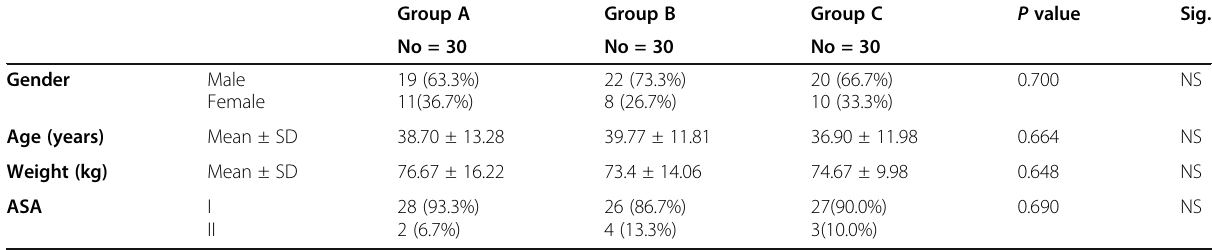
Table 1 Comparison between groups A, B, and C as regards demographic data